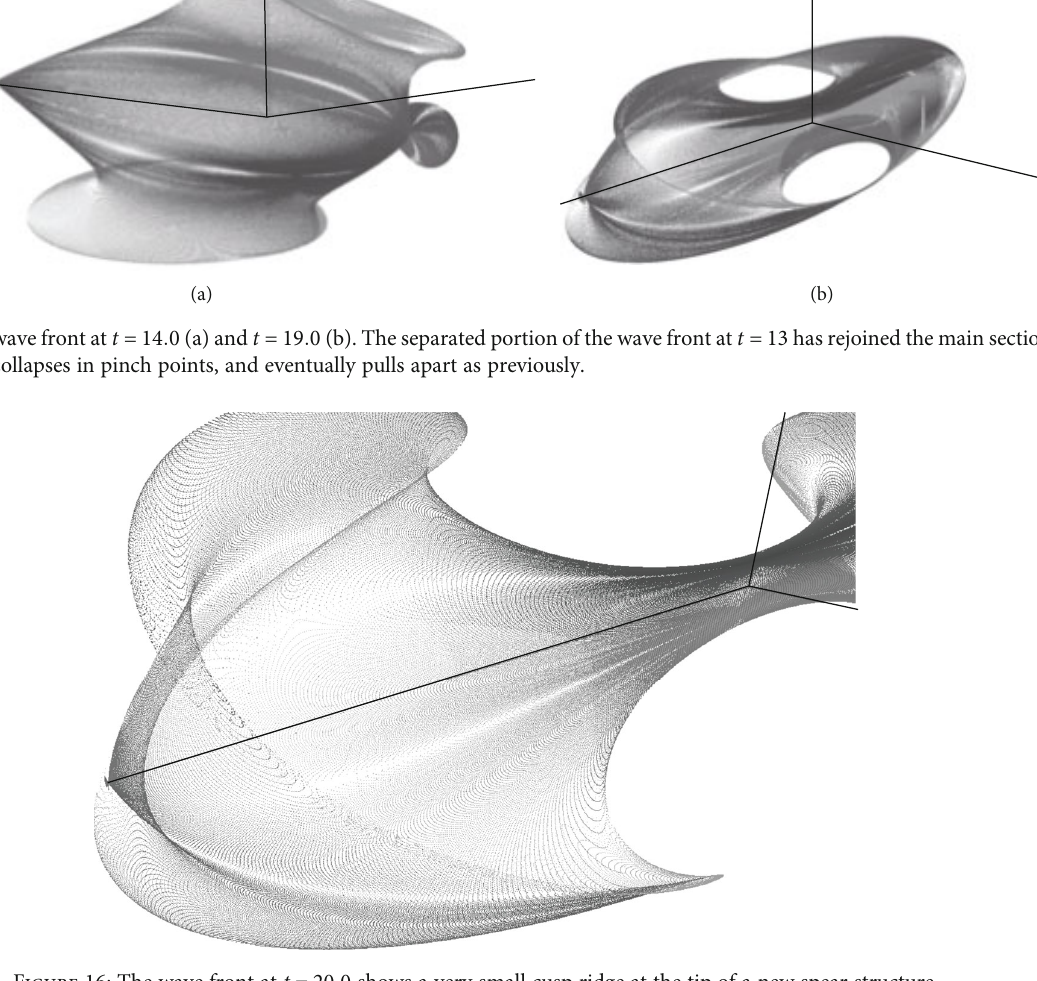
Figure 16: The wave front at t = 20 : 0 shows a very small cusp ridge at the tip of a new spear